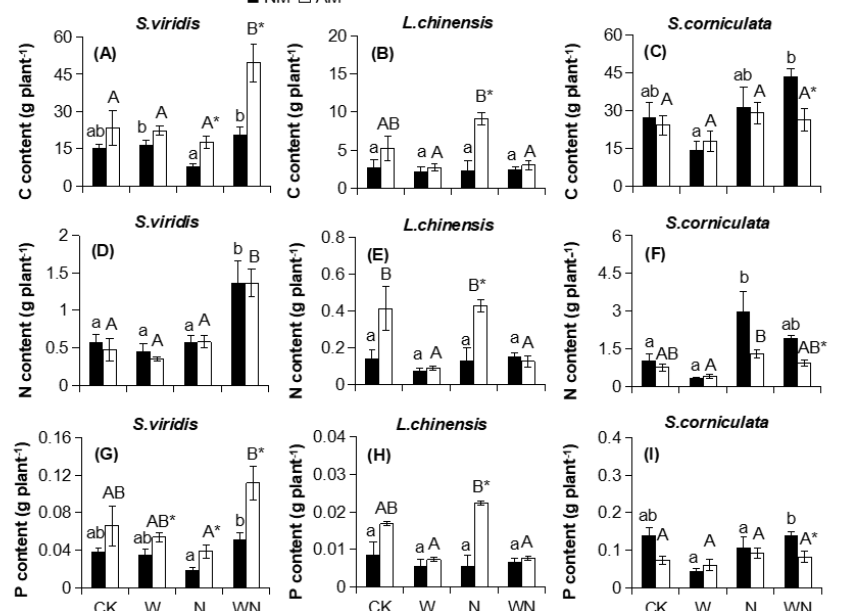
Figure 1. Effects of AMF on the C, N, and P contents of S. viridis ( A , D , G ), L. chinensis ( B , E , H ), and S. corniculata ( C , F , I ) under warming and N input. Different lowercase and capital letters above bars indicate significant differences ( p < 0.05) among different warming and N input treatments within the same AMF treatment. Asterisks indicate significant differences ( p < 0.05) between AMF treatments within the same warming and/or N input condition. CK, control; N, N input; W, warming; and WN, combination of warming and N input. AMF increased the C:N ratio of S. viridis by 74% ( p < 0.01), 57% ( p < 0.05), 122% ( p < 0.001), and 121% ( p < 0.01; Figure 2A) in the control, warming, N input and combination of warming and N input, respectively . AMF decreased the C:N ratio of L. chinensis by 36% ( p < 0.001) in the CK treatment, but in the N and WN treatments, AMF increased the C:N ratio of L. chinensis by 17% ( p < 0.01) and 48% ( p < 0.001; Figure 2B), respectively. There were significant effects of AMF × W and AMF × N on the C:N ratio of L. chinensis (Table 2). AMF significantly increased the C:N ratio of S. corniculata by 114% ( p < 0.001) and 25% ( p < 0.01; Figure 2C) in the N and WN treatments, respectively. AMF increased the C:P ratio of S. viridis by 11% ( p < 0.05; Figure 2D) in the WN treatment and that of S. corniculata by 18% ( p < 0.05; Figure 2F) in the CK treatment; it had no impact in the other treatments. There were significant effects of AMF × N on the C:P ratios of S. viridis and L. chinensis and of AMF × W and AMF × W × N on the C:P ratio of S. corniculata (Table 2) . AMF decreased the N:P ratio of S. viridis by 51%, 48% ( p < 0.01), 51% ( p < 0.001), and 52% ( p < 0.01; Figure 2G) in the control, warming, N input and combination of warming and N input, respectively . AMF increased the N:P ratio of L. chinensis by 46% ( p < 0.01) in the CK treatment but decreased that of L. chinensis by 16% ( p < 0.05) and 27% ( p < 0.01; Figure 2H) in the N and WN treatments, respectively. AMF decreased the N:P ratio of S. corniculata by 49% ( p < 0.001) and 15% ( p < 0.05; Figure 2I) in the N and WN treatments, respectively. There were significant effects of AMF × N on the N:P ratio of all three species and of AMF × W and AMF × W × N on the N:P ratio of L. chinensis and S. corniculata (Table 2).